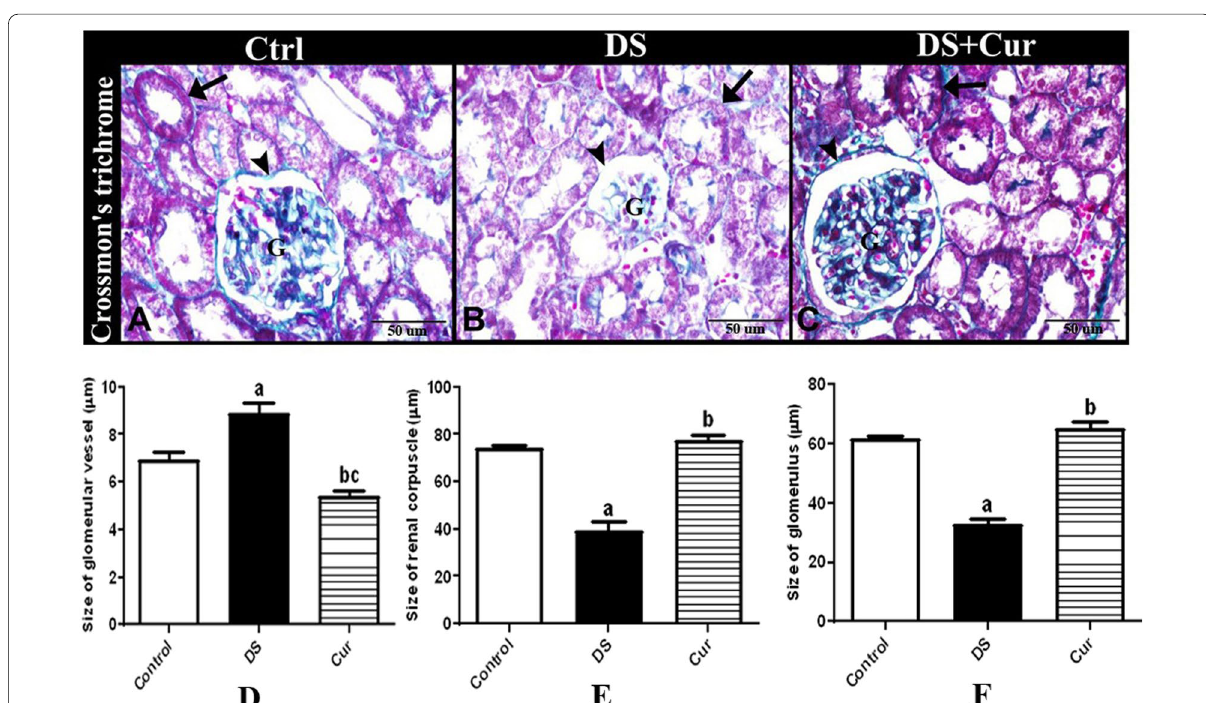
Fig. 5 Photomicrographs of paraffin sections stained with Crossmon’s trichrome technique illustrated the protective effect of curcumin (Cur) on diclofenac sodium (DS) induced renal damage in rat. A The kidney of control (Ctrl) group showed normal collagen contents in glomeruli (G) in the continuous renal tubular basement membrane (arrow) and in the continuous basement membrane of the parietal layer of the Bowman’s capsule (arrowhead). B The kidney of DS group showed a less collagen contents in glomeruli (G) in the thin disrupted renal tubular basement membrane (arrow) and in the thin disrupted basement membrane of the parietal layer of the Bowman’s capsule (arrowhead). C The kidney of diclofenac sodium curcumin (DS Cur) group showed restoration of the normal collagen contents in glomeruli (G) in the continuous renal tubular + + basement membrane (arrow) and in the continuous basement membrane of the parietal layer of the Bowman’s capsule (arrowhead). Original magnification X400, scale bar 50 μm. D Histogram showed that the size of glomerular vessels significantly increased in DS group compared to = the control group, and oral supplementation of Cur restored the normal size of the glomerular vessels. E Histogram showed that the size of the renal corpuscles significantly decreased in DS group compared to the control group, and oral supplementation of Cur restored the normal size of the renal corpuscles. F Histogram showed that the size of the glomerulus significantly decreased in DS group compared to the control group, and oral supplementation of Cur restored the normal size of the glomerulus. Results are expressed as mean SEM (6 mice/group). Data are analyzed ± by one‑way ANOVA followed by Duncan posttest. a indicates significant difference between control and DS groups at p < 0.05; b indicates significant difference between DS and DS Cur groups at p < 0.05; c indicates significant difference between control and DS Cur groups at p < + +